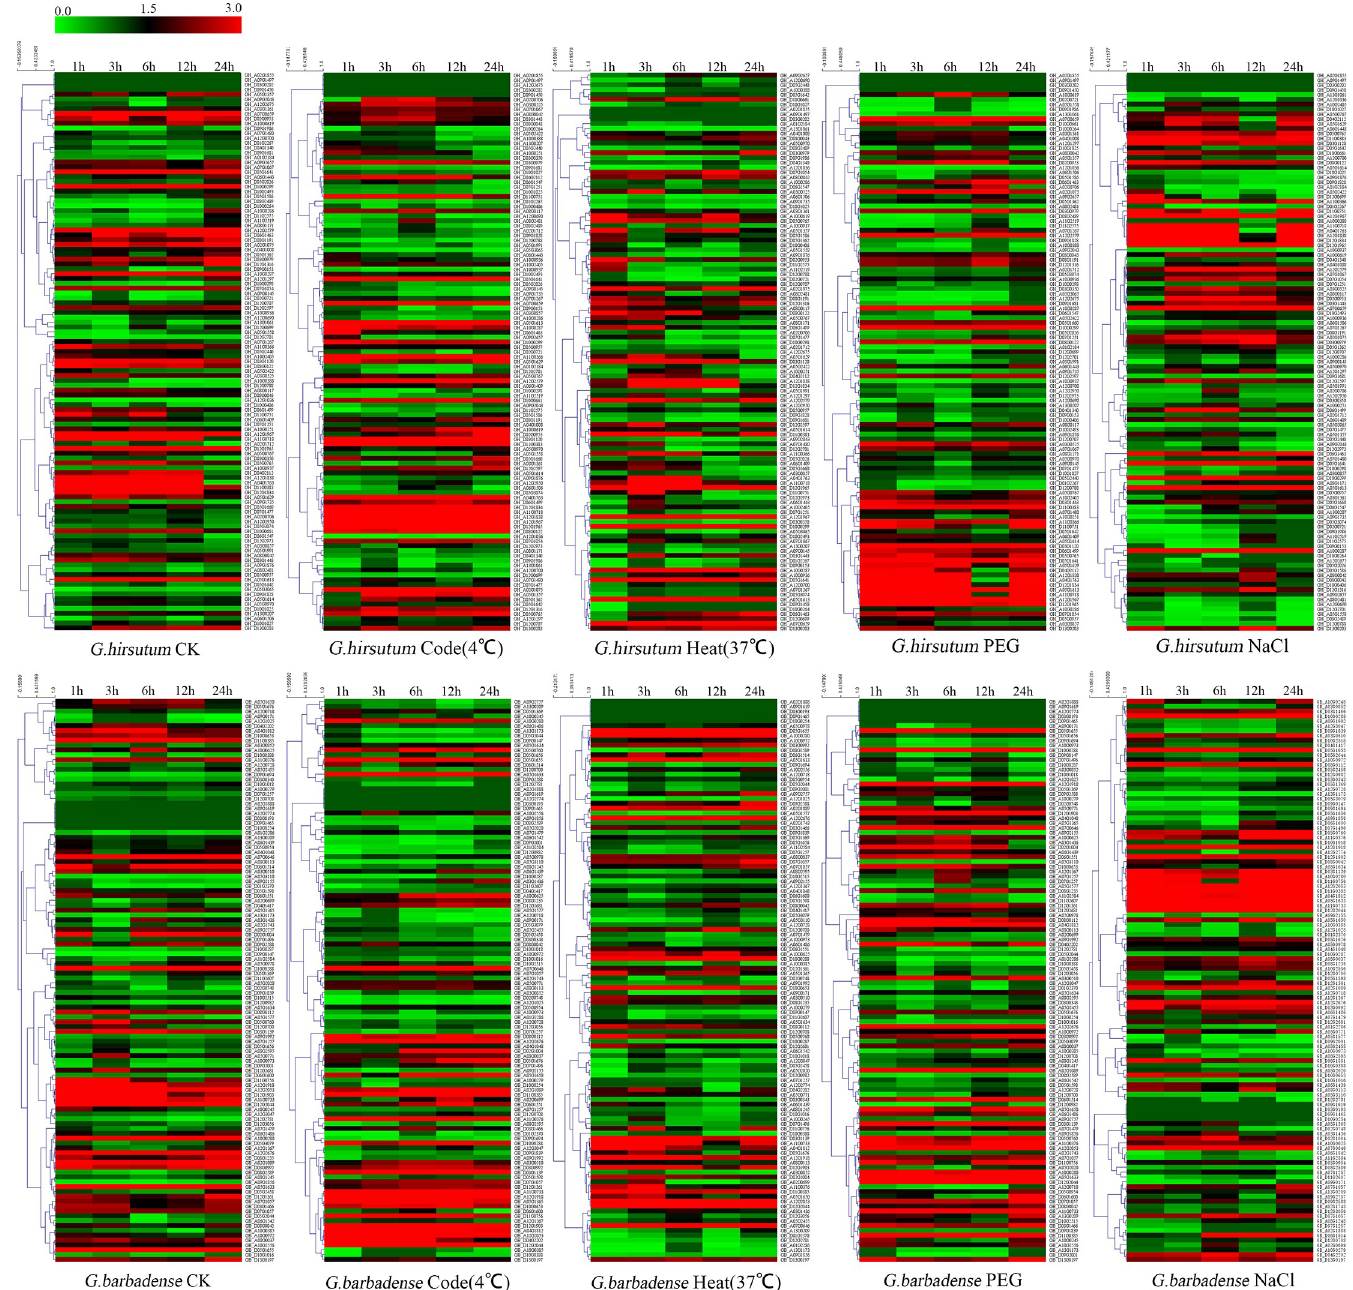
Fig 5. Expression patterns of Dof genes under normal condition (CK), cold, heat, PEG and salinity conditions for 1h, 3h, 6h, 12h and 24h.